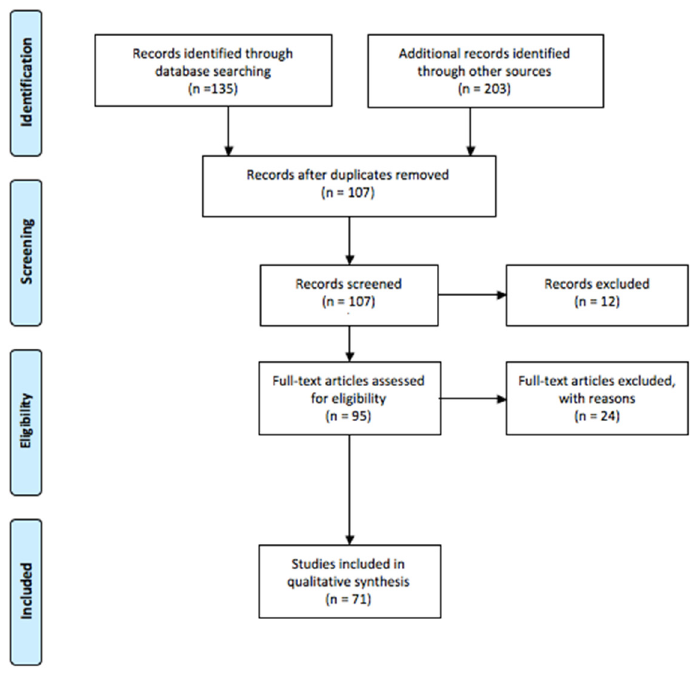
Figure 1. Flow chart of the literature research for two independent reviewers .